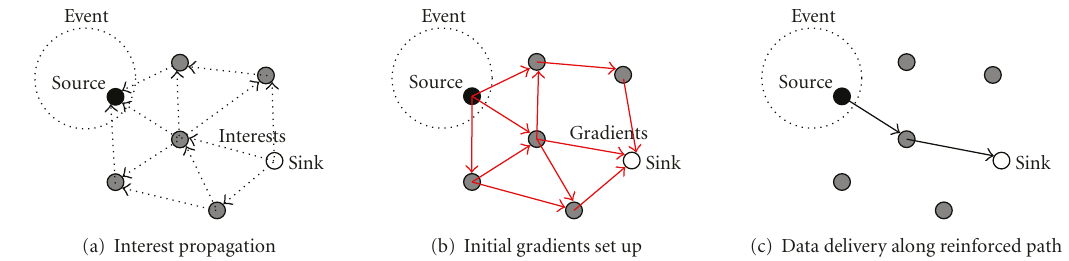
Figure 1: Schematic illustration of directed di ff usion.